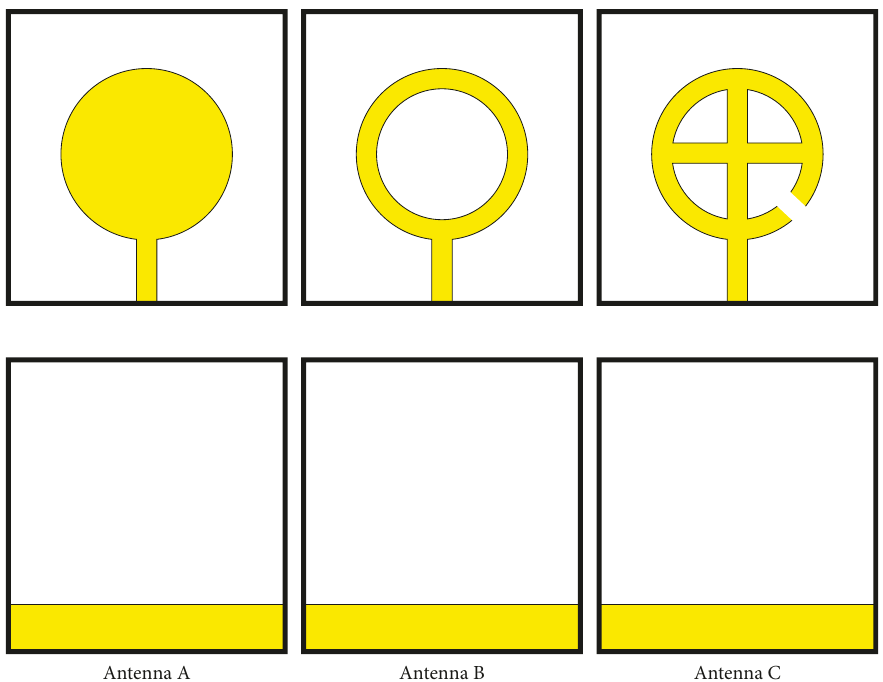
Figure 1: Step by step design of the C-shaped antenna with stub.